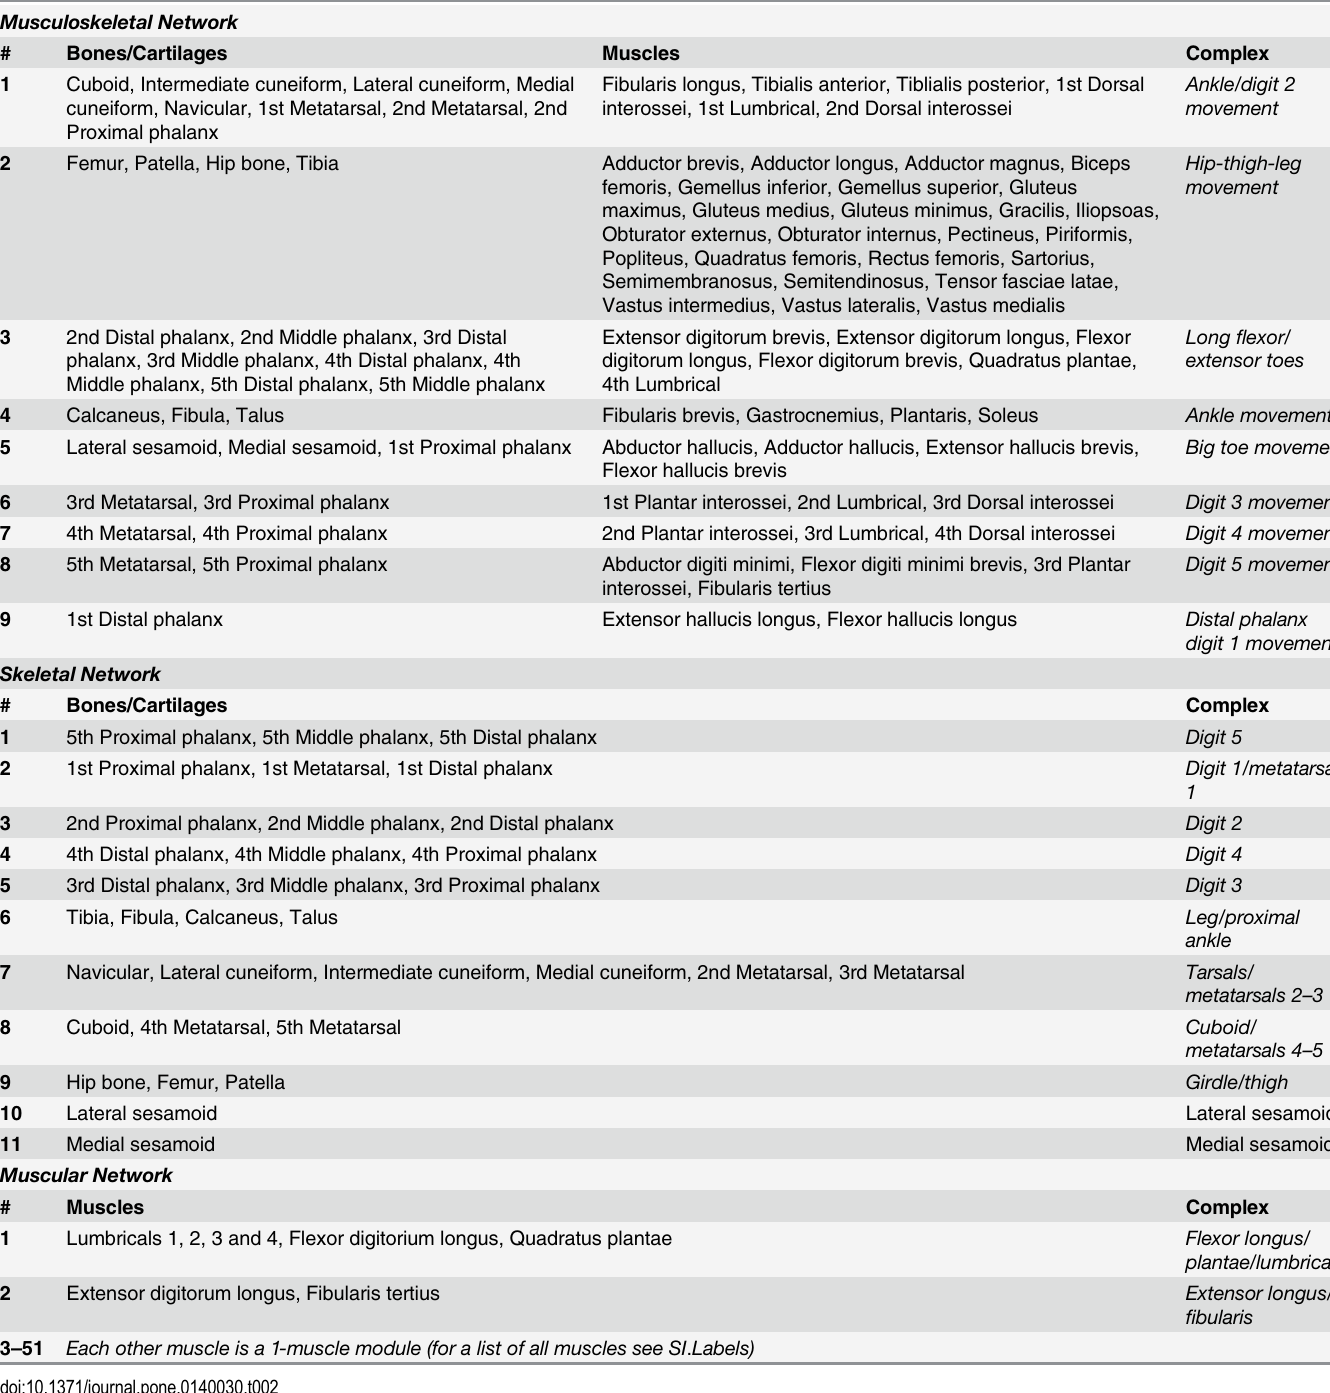
Table 2. Phenotypic modules in the lower limb of the normal